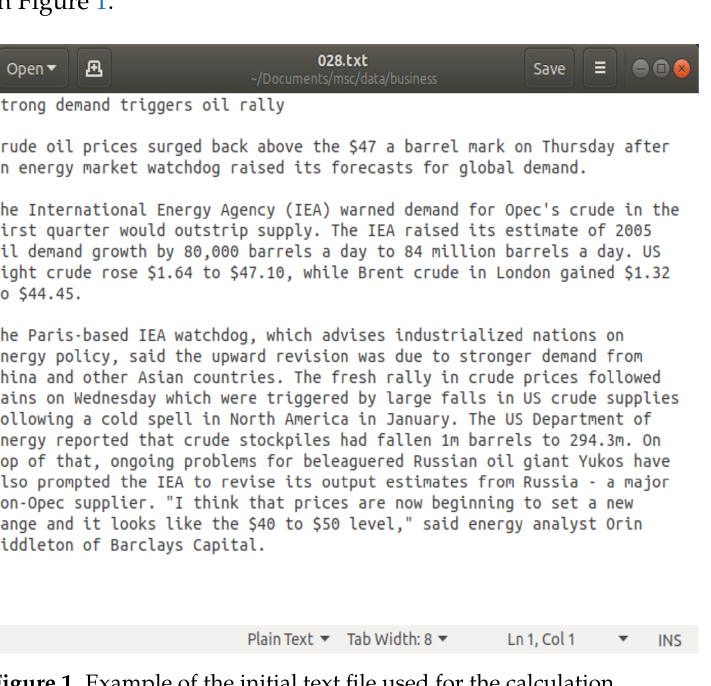
Figure 1. Example of the initial text file used for the calculation.